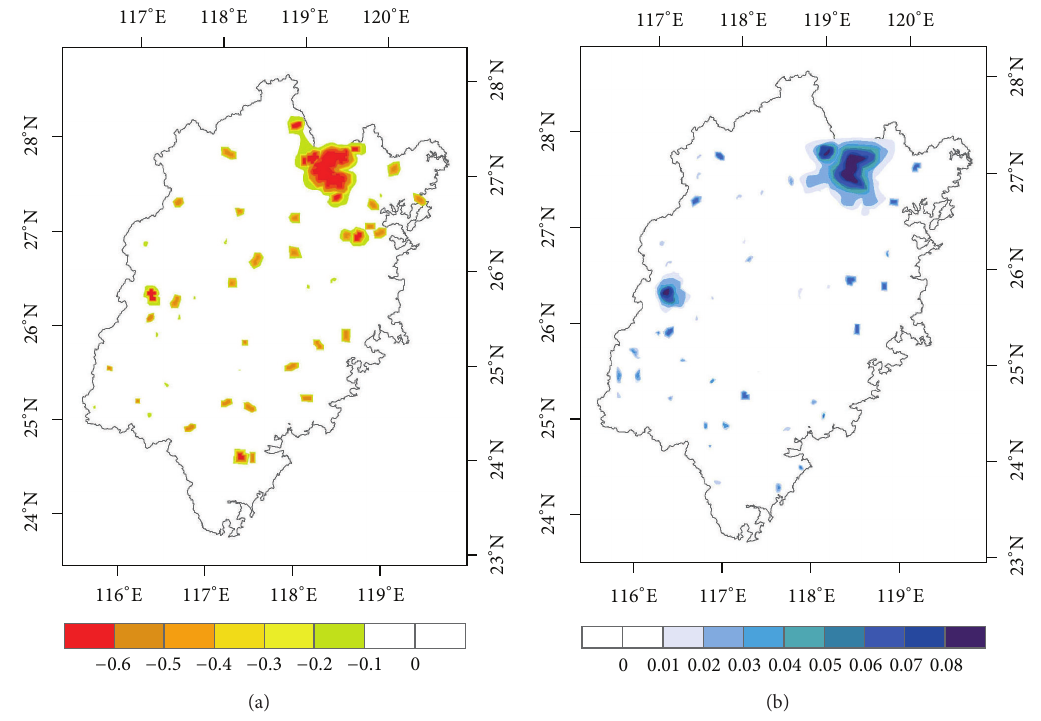
Figure 3: Seasonal difference of near-surface temperature at 2 meters height (unit: ∘ C) in the experiment of conversion from grassland to forestland in Fujian province, 2000–2008. (a) and (b) identify the temperature difference in summer and winter, respectively.